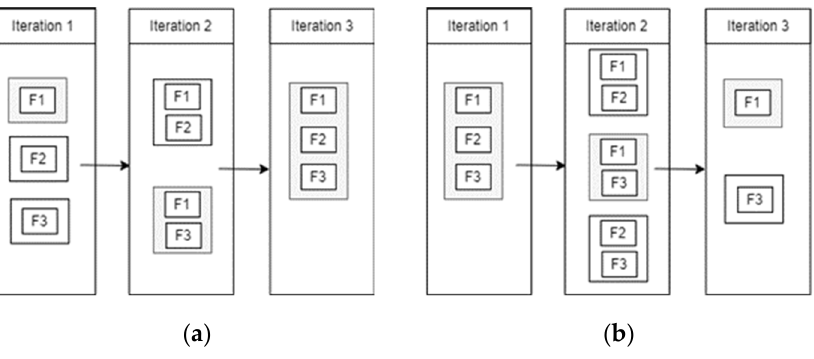
Figure 1. ( a ) An example of SFS; ( b ) an example of SBS.